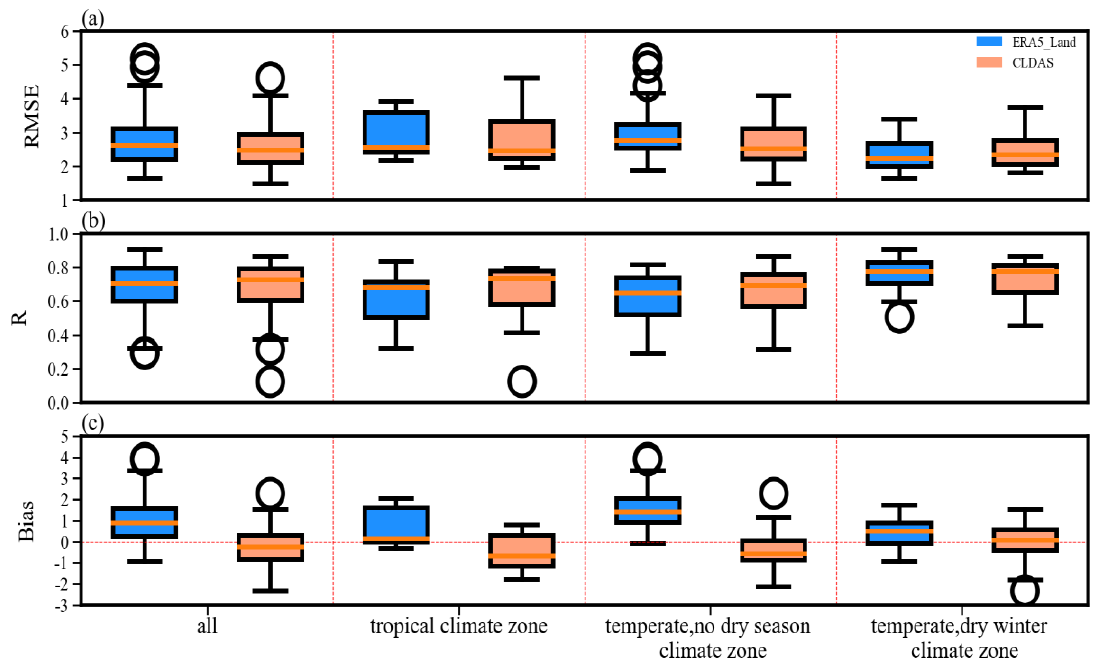
Figure 4. RMSE ( a ), R ( b ), and Bias ( c ) of the SWDI between the ERA5-Land and in situ data and between the CLDAS and in situ data in the whole study area and the three climate zones. RMSE is root mean squared error, R is correlation coefficient, and Bias is bias.